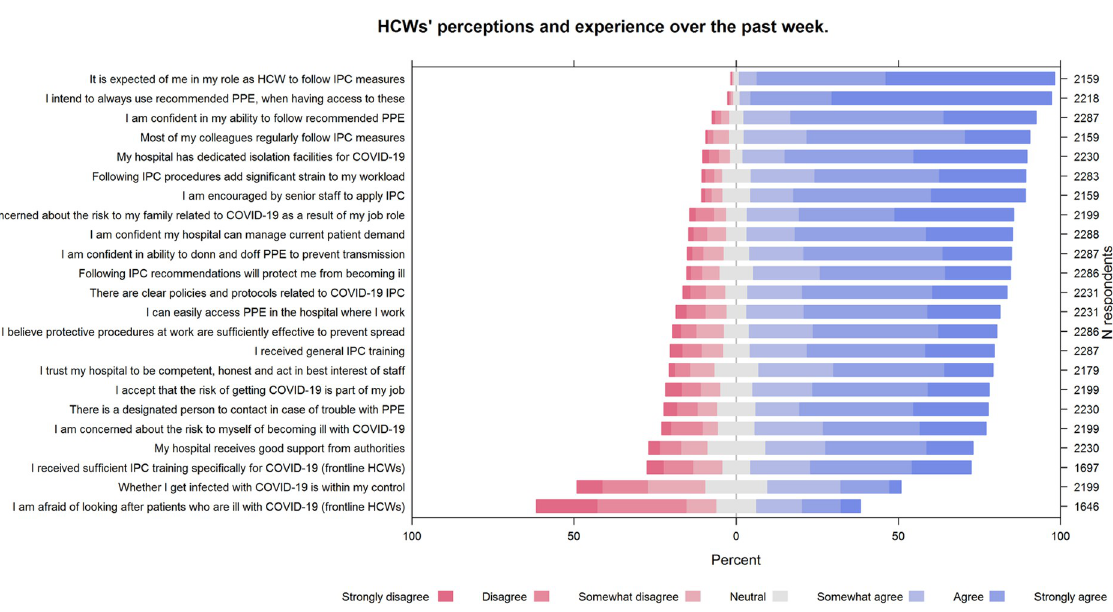
Fig 1. Perceptions of hospital healthcare workers on recommended IPC procedures, perceived skills, intentions and environmental resources. HCWs, health care workers; IPC, infection prevention and control; PPE; personal protective equipment. NB. Individual statements were abbreviated for readability of this figure (see S1 File for all complete statements used in the surveys).